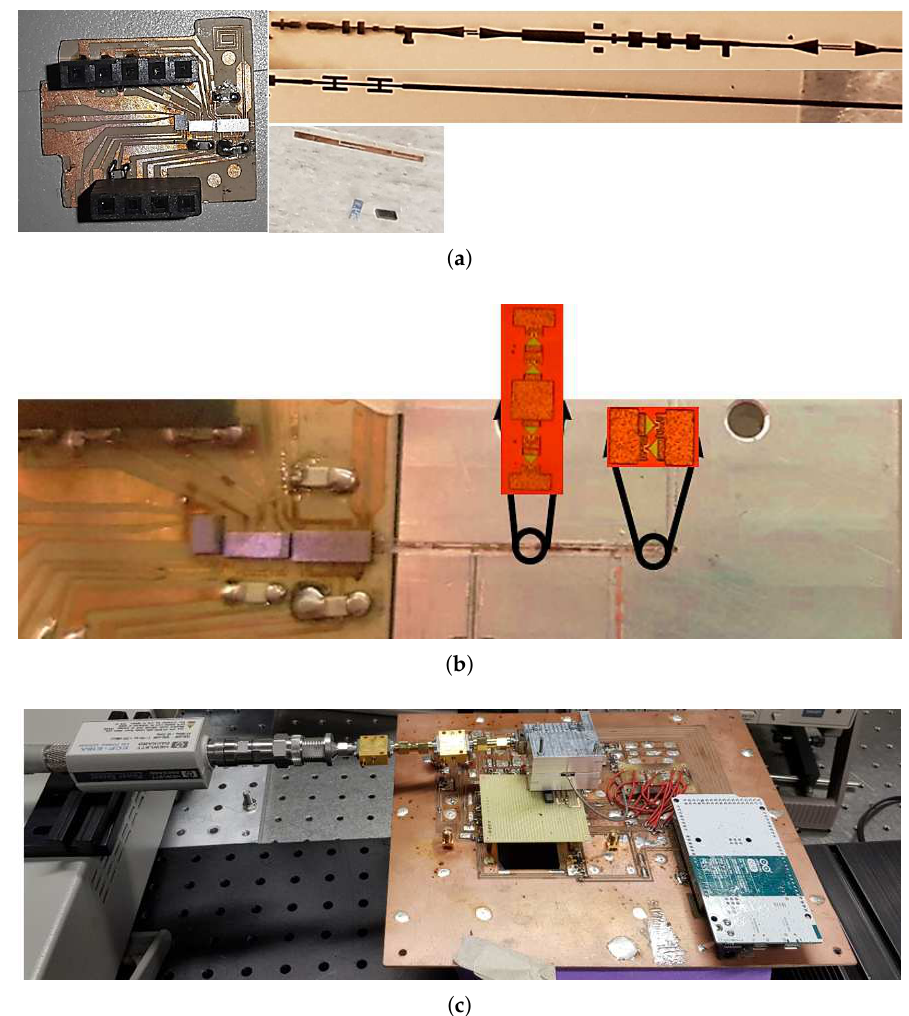
Figure 8. Photographs of: ( a ) (left) Prototype of local oscillator and (right) prototypes of doubler/mixer, IF hammerhead filter and LPF DC bias printed on Topas COC substrate with discrete diodes for size comparison; ( b ) Subharmonic mixer and the local oscillator in the enclosed metallic block with zoom of the UMS Schottky diodes and ( c ) Setup for Y-Factor measurement where the board with Arduino Due for LO tuning can be